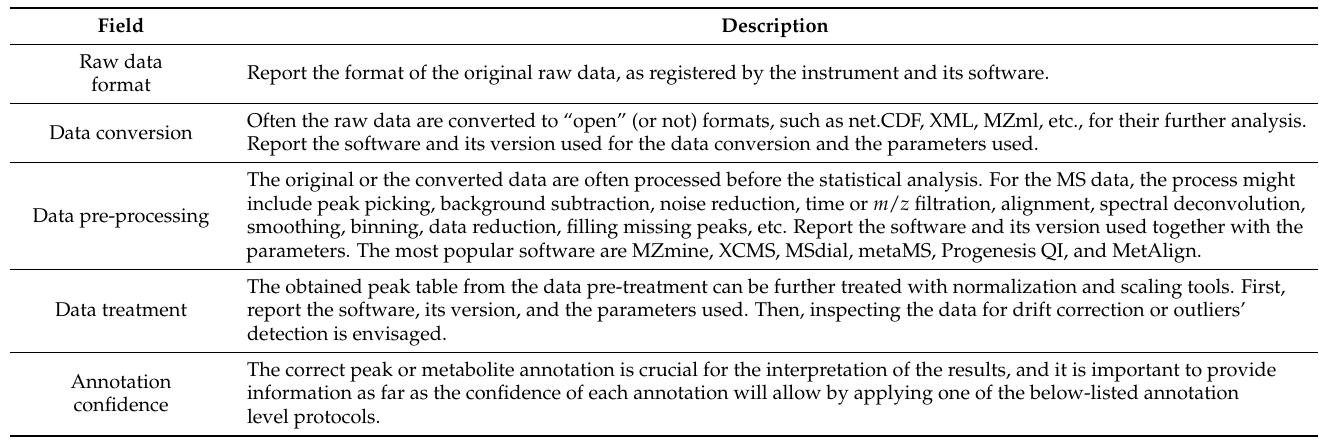
Table 4. Data transformation/conversion parameters protocol and metabolite